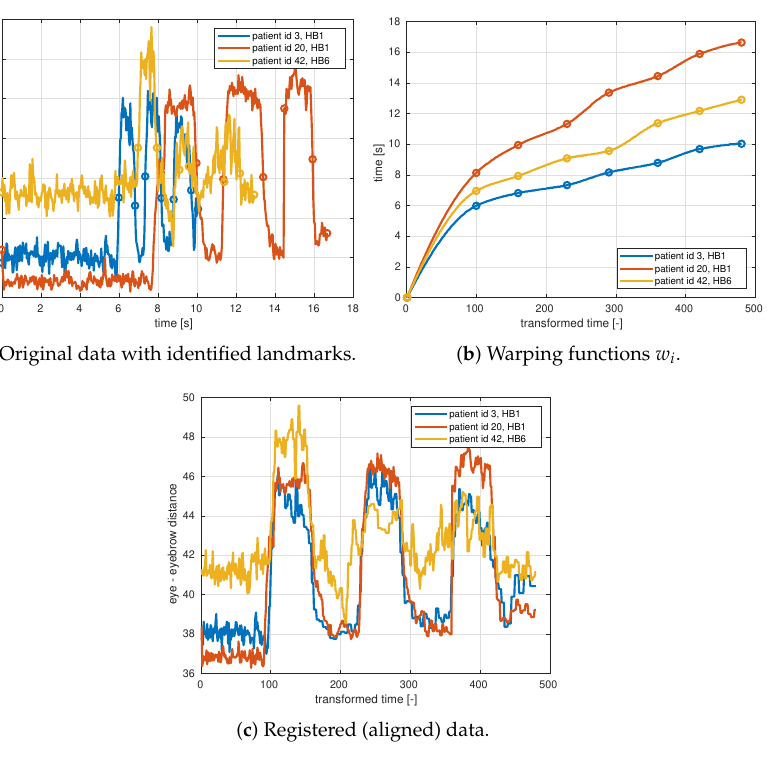
Figure 4. Alignment of data illustrated on the sum of left and right distance between eye corners and eyebrows for three different patients performing Raising